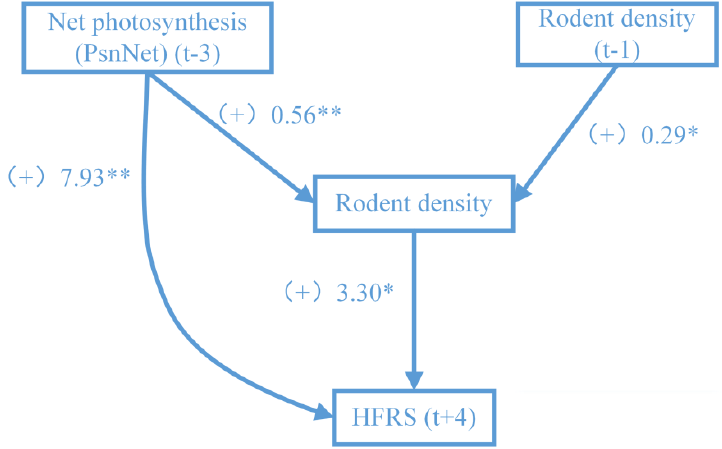
Figure 7. Structural equation model for net photosynthesis (PsnNet), rodent population density and incidence of hemorrhagic fever with renal syndrome (HFRS). ( χ 2 = 2.34, CFI = 0.97). * Parameter is significant at the 0.05 level. ** Parameter is significant at the 0.01